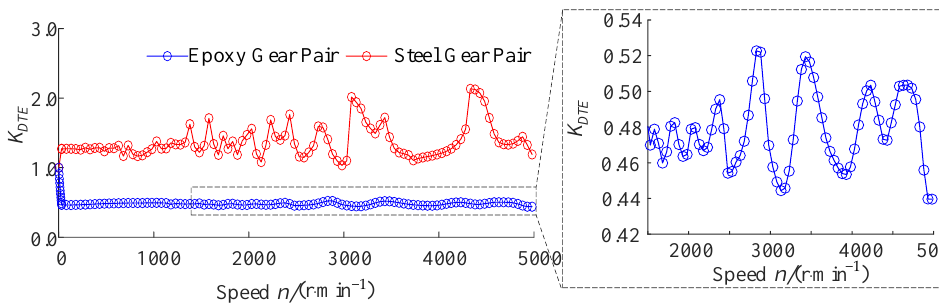
Figure 9. Comparison of 𝐾 𝐷𝑇𝐸 between the epoxy gear pair and the steel gear pair.